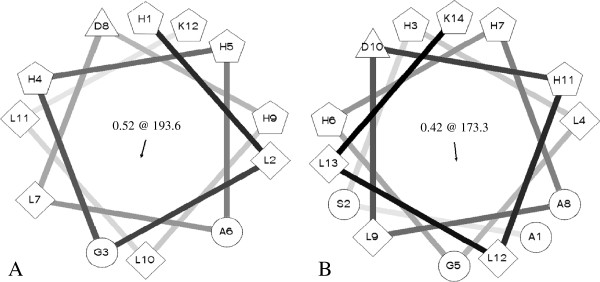
Edmundson wheel projection of (A) Holothuroidin 1 and (B) Holothuroidin 2 calculated by the Helical Wheel Projection web tool. Residues are schematically represented by geometric figures. Hydrophilic residues = circles, hydrophobic residues = diamonds, potentially negatively charged = triangles, and potentially positively charged = pentagons. In the centre mean relative hydrophobic moment and hydrophobic arc (@) are indicated.